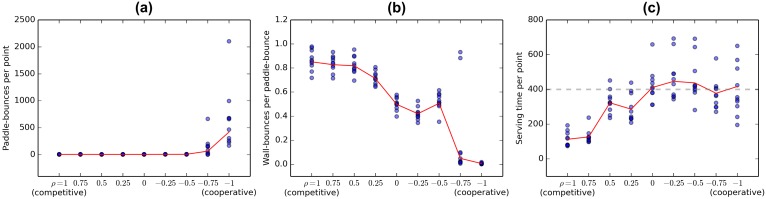
Progression of behavioral statistics when passing from competitive to collaborative rewarding scheme.Each blue dot corresponds to the average of one game. Red line depicts the average across games (also given in S2 Table). (a) The game lasts longer when the agents have a strong incentive to collaborate. (b) Forcing the agents to collaborate decreases the proportion of angled shots that bounce off the walls before reaching the opposite player. Notice the two aberrant values for ρ = −0.75 correspond to games where the agents never reach the collaborative strategy of keeping the ball alive by passing it horizontally. (c) Serving time decreases when agents receive stronger positive rewards for scoring.